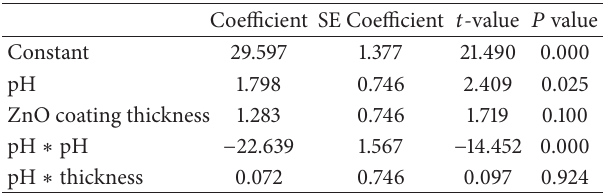
Table 4: ANOVA of surface response methodology for the photo- catalytic process of dairy